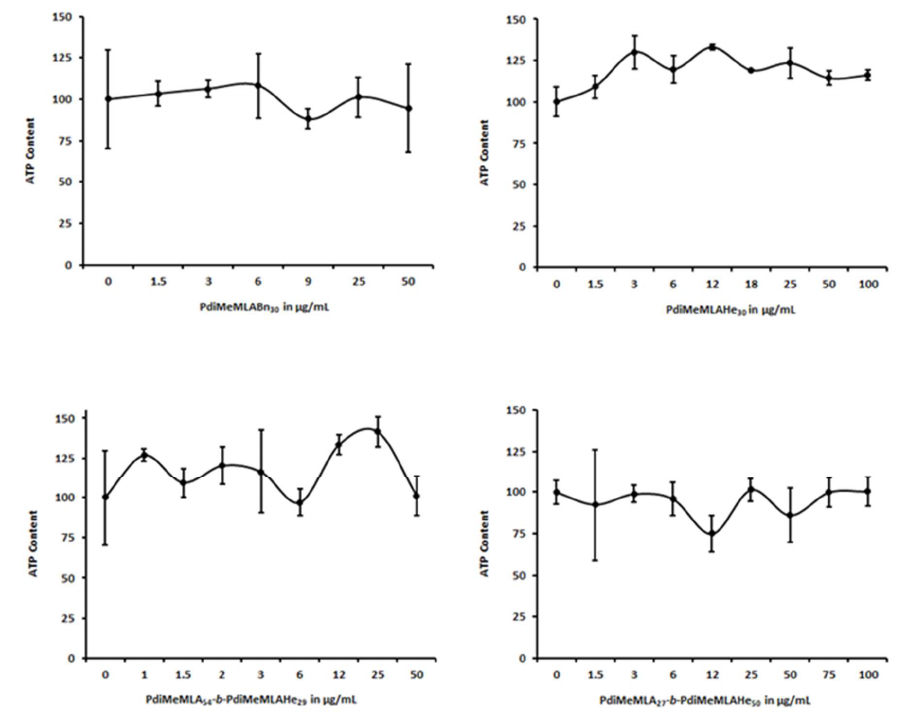
Figure 6. Di ff erentiated HepaRG cell viability evaluated by measuring the ATP content at 24 h of incubation with increasing concentrations of (co)polymers PdiMeMLA 54 - b -PdiMeMLAHe 29 , PdiMeMLA 27 - b -PdiMeMLAHe 50 , PdiMeMLABn 30 and PdiMeMLAHe 30 NPs.